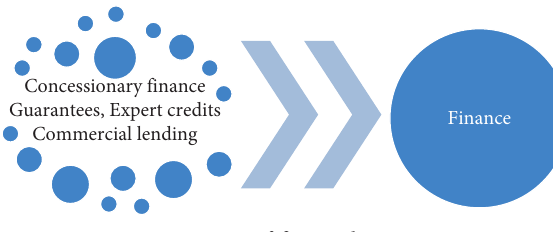
Figure 1: Range of financial